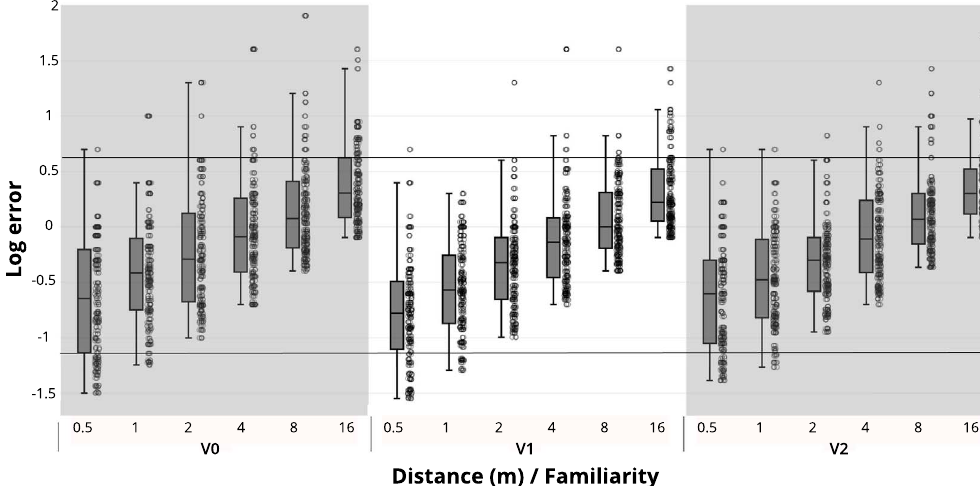
Figure 4. Log-distance errors for different distances and familiarity levels.